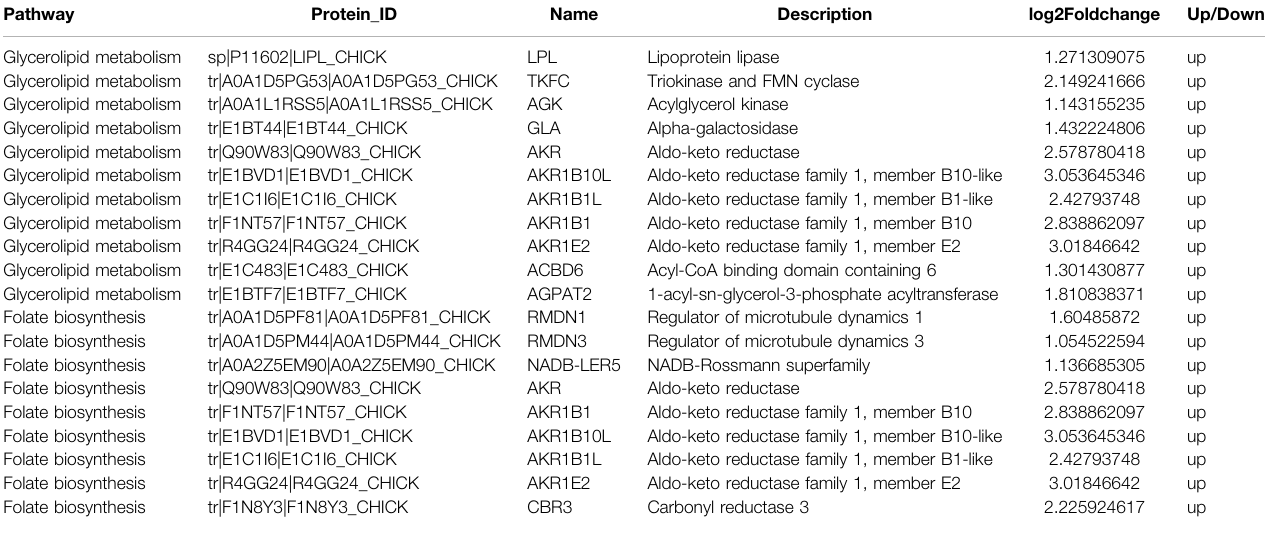
TABLE 3 | Pathway relationship networks of DEPs enriched in the glycerolipid metabolism pathway and folate biosynthesis pathway.